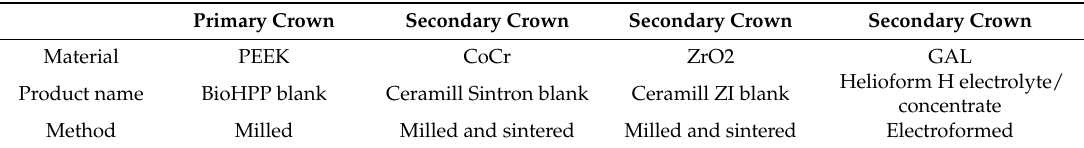
Table 1. An overview of all materials, product names and fabrication methods of primary and secondary crowns.